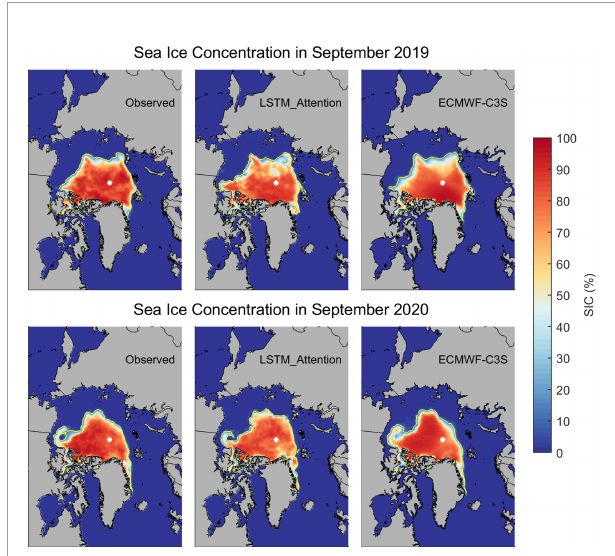
FIGURE 8 | Observed SIC and predicted SIC by LSTM_Attention, and ECMWF-C3S in September 2019 (upper panel) and September 2020 (lower panel). The yellow line in each subplot represents the observed or predicted ice edge for that